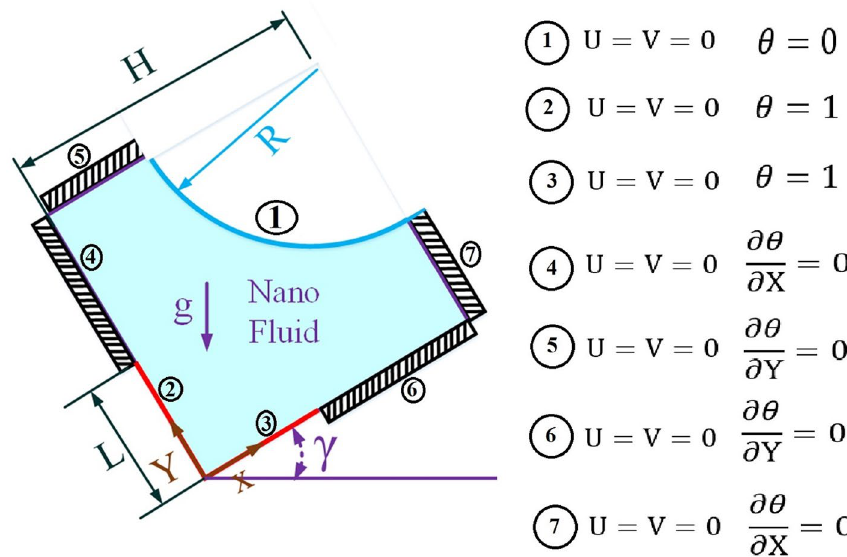
Figure 2. Dimensionless boundary conditions.